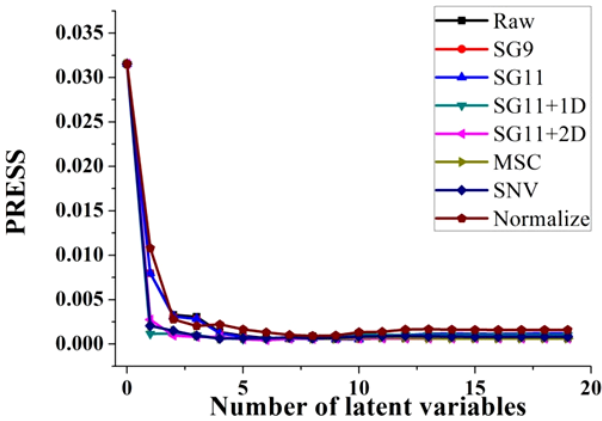
Fig. 1. PRESS plot of CPM with di®erent pretreatment methods.